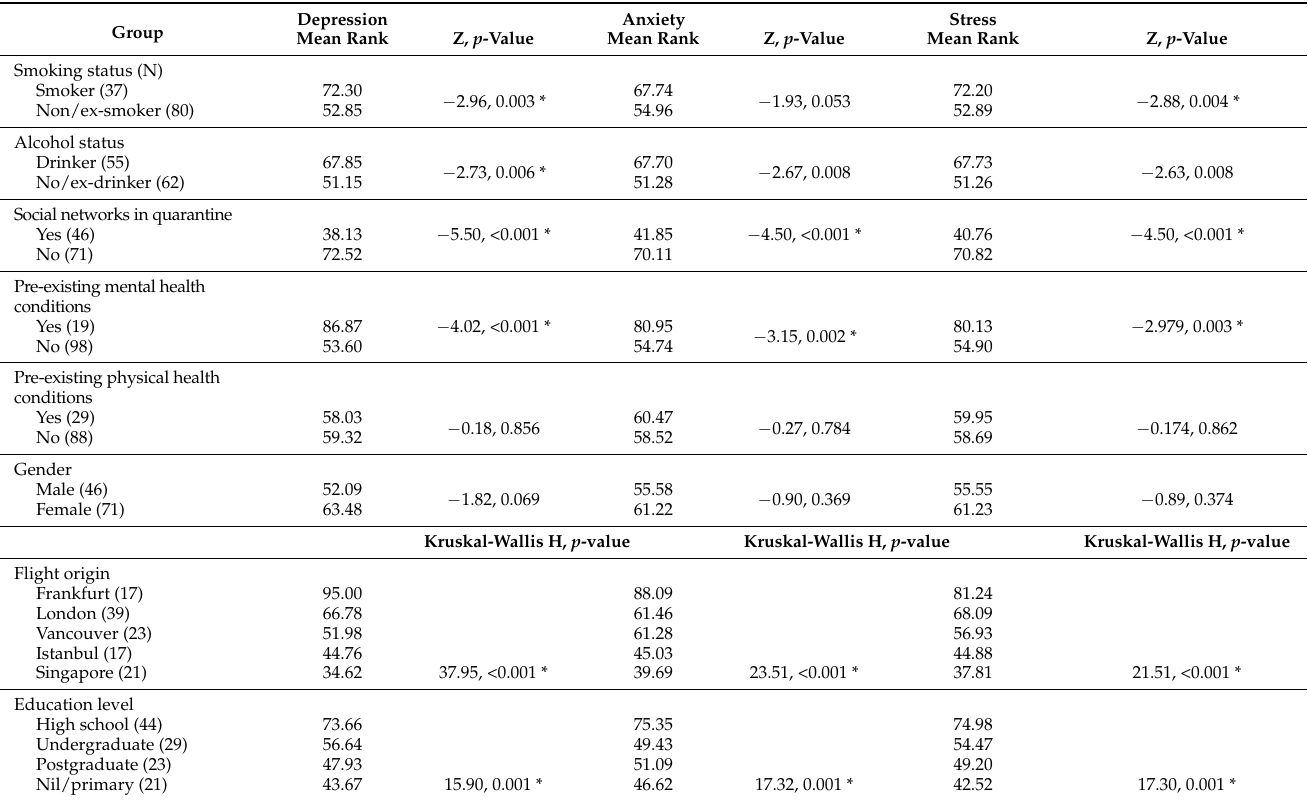
Table 5. The differences in psychological distress across groups.